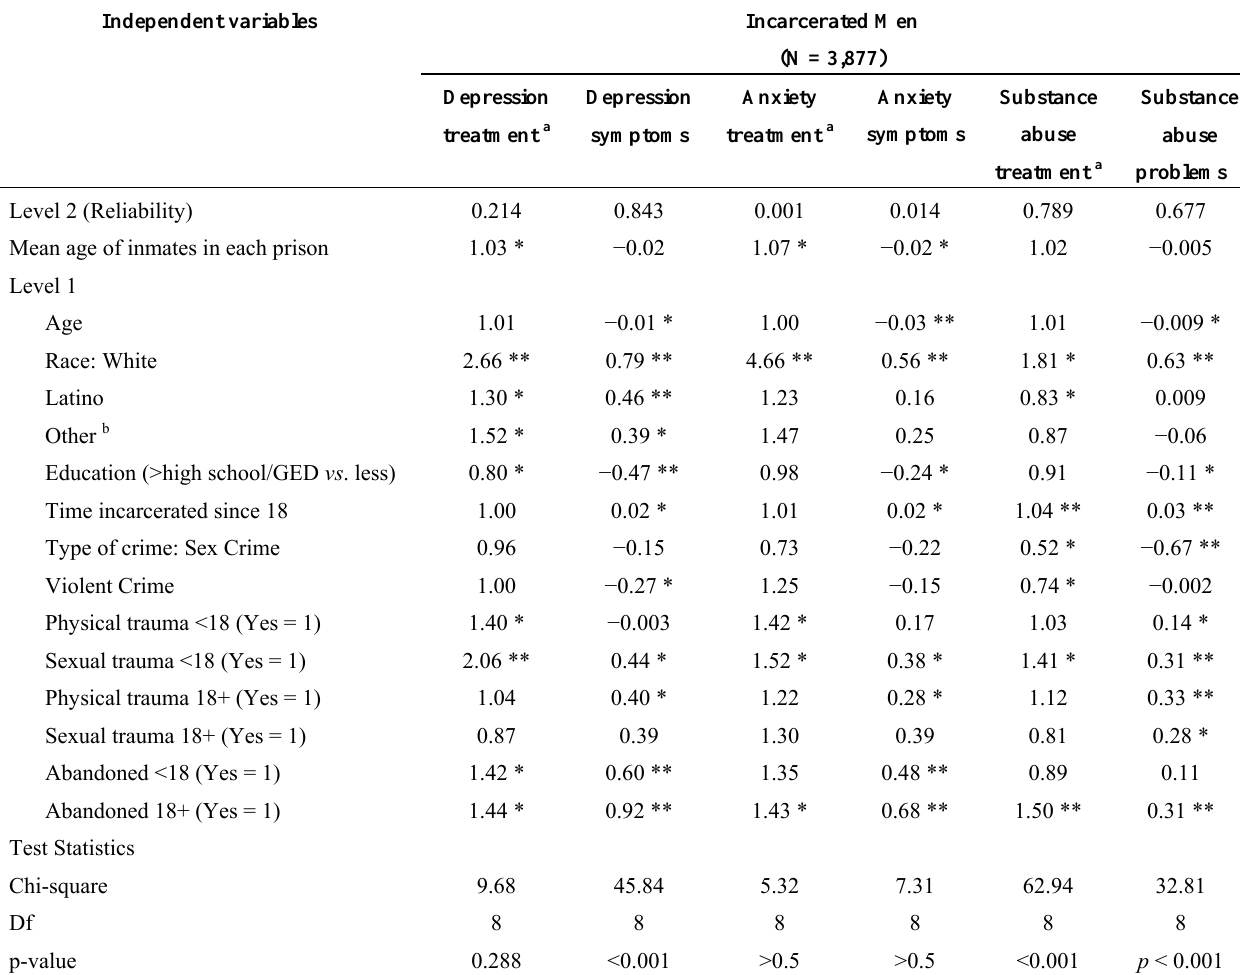
Table 3. Coefficients and odds ratios for behavioral health problems by individual characteristics of incarcerated